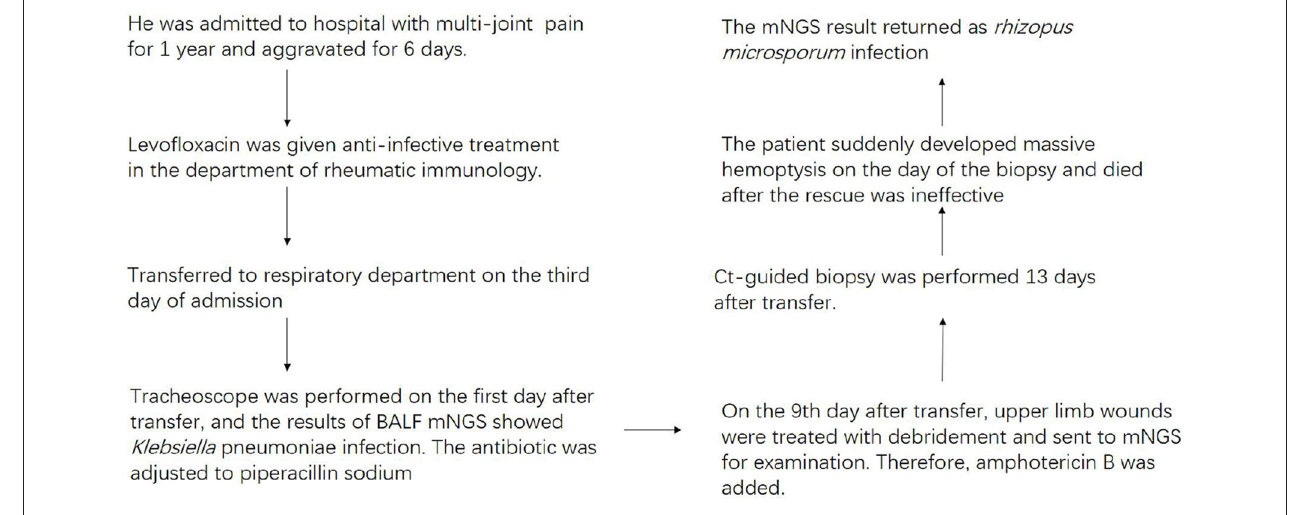
FIGURE 3 | Diagnosis and treatment of the